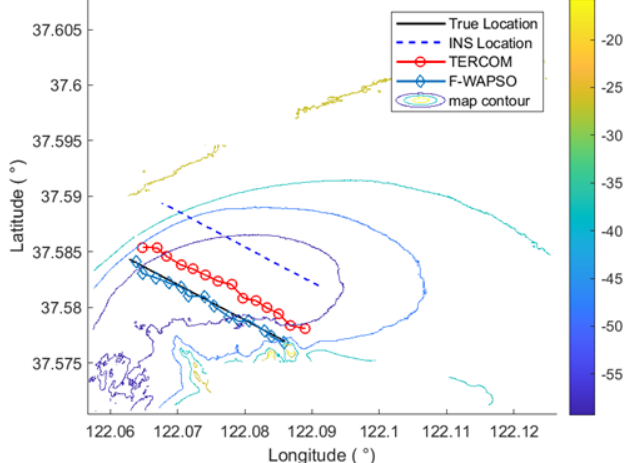
Figure 8. Trajectory C matching results of the two algorithms.